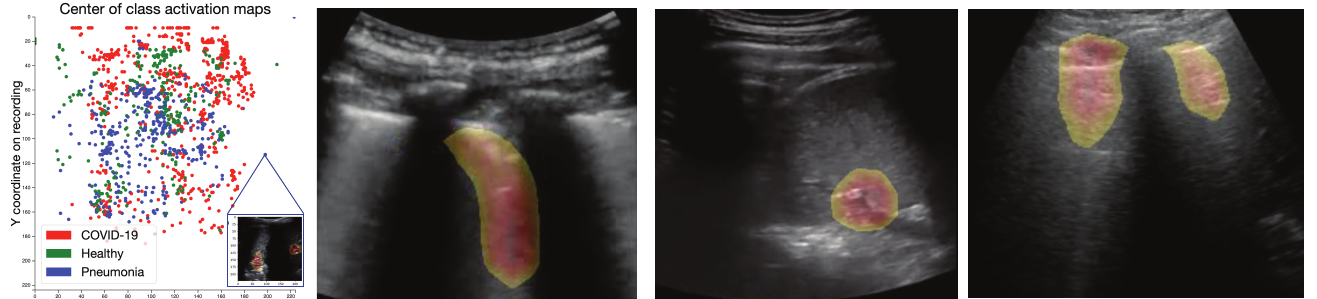
Figure 5. Class activation maps. ( Left ): Interactive scatterplot of the origins of the CAMs across the entire dataset, colored by class. While the data seems rather unstructured, pneumonia-CAMs have lower y -coordinates than COVID-19 and healthy samples. ( Rest ): Exemplary CAMs for COVID-19 (highlighting a B-line), bacterial pneumonia (highlighting pleural consolidations) and healthy lungs (highlighting